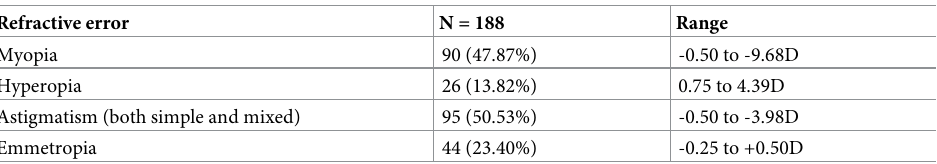
Table 1. Distribution of refractive error in the